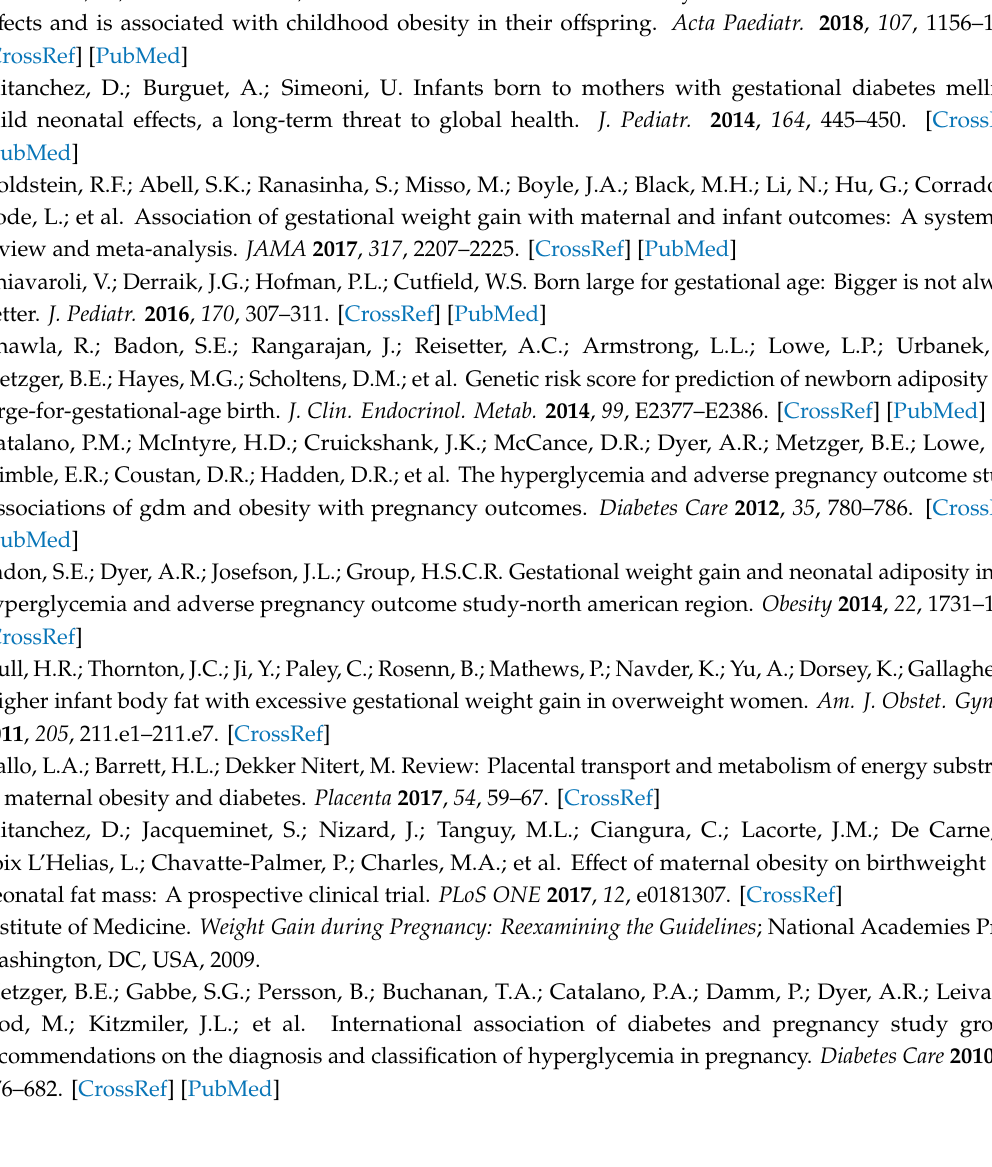
Table S1: Evaluation of the multicollinearity between the variables included in the multivariate analysis. Table S2: Contribution of 1kg weight gain relative to the class centre of recommended GWG by the IOM on birth weight, skinfold thickness and cord leptin level. Table S3: Contribution of 1st trimester gestational weight gain on birth weight, skinfold thickness and cord leptin level. Table S4: Contribution of 2nd trimester gestational weight gain on birth weight, skinfold thickness and cord leptin